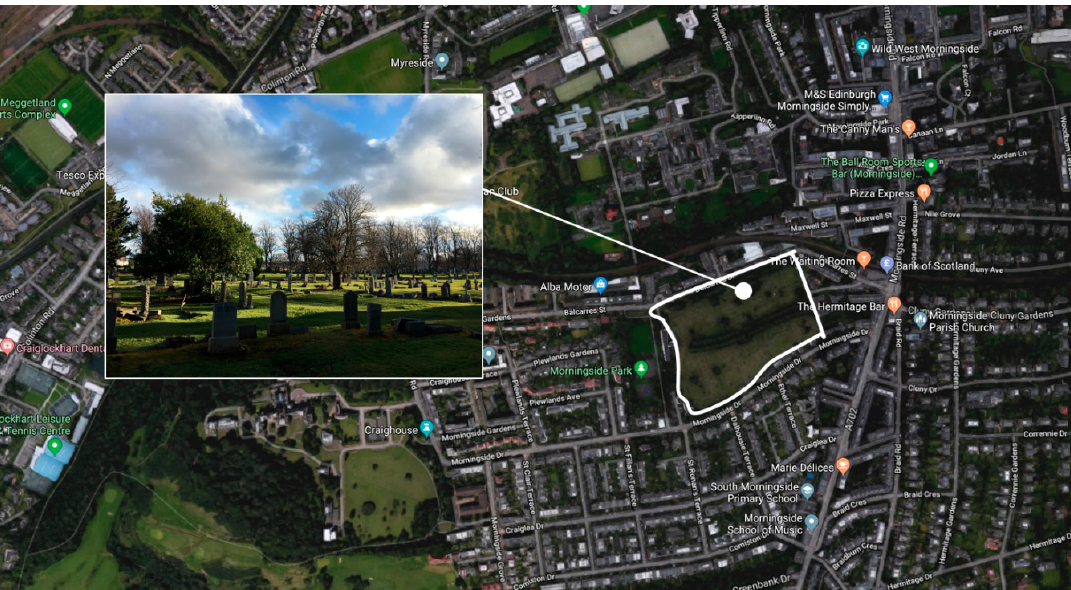
Figure 3. Map and image of the Morningside Cemetery in Edinburgh (the map was retrieved from www.google.no/maps/). The white spot indicates the location where data collection was conducted, and the white line indicates the boundary of the Morningside Cemetery.